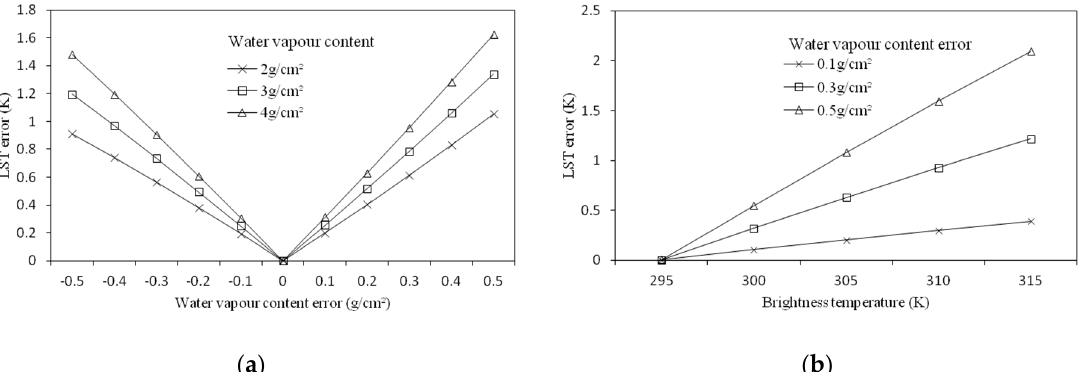
Figure 12. LST estimation error of the single-channel method as a result of the estimation error in the water vapor content. ( a ) LST error against water vapor content error, and ( b ) LST error against brightness temperature for different water vapor content error; water vapor content was kept constant at 2.09 g/cm².